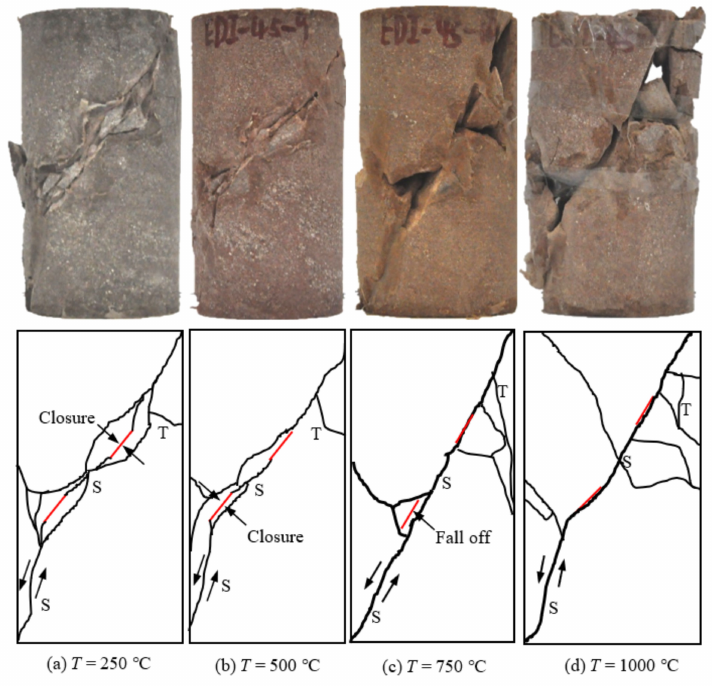
Figure 11. Relationships between stress ratio with steady-state strain ratio and damage after different temperature